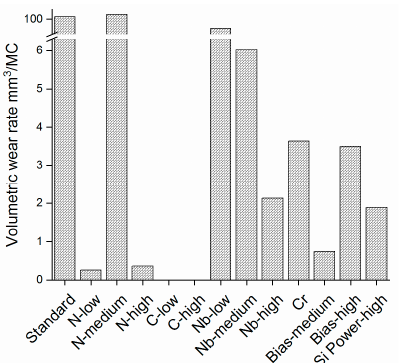
Figure 5. Volumetric wear rate for the UHMWPE pins ran against all coatings in this study. Coatings C-high and C-low showed negative values of − 2.90 and − 8.40 mm 3 /MC, respectively.